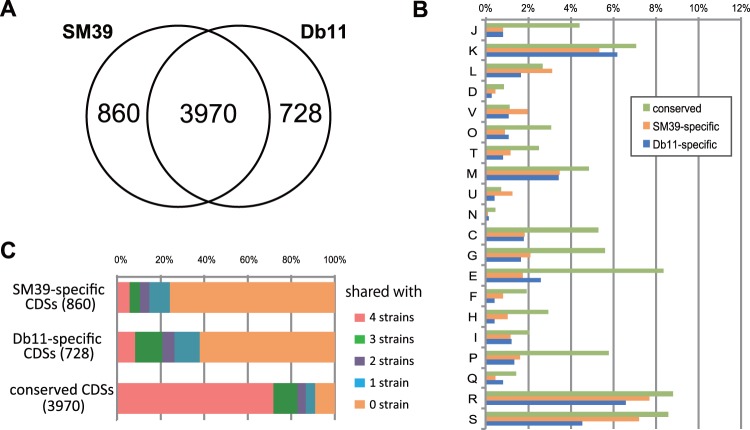
Comparison of the gene contents of SM39 and Db11. (A) Venn diagram showing the numbers of conserved and strain-specific CDSs. (B) COG category-based functional analysis of each group of CDSs, the conserved and strain-specific CDSs. J: translation, ribosomal structure, and biogenesis; K: transcription; L: replication, recombination, and repair; D: cell cycle control, cell division chromosome partitioning; V: defense mechanisms; O: posttranslational modification, protein turnover, and chaperones; T: signal transduction mechanisms; M: cell wall/membrane/envelope biogenesis; U: intracellular trafficking, secretion, and vesicular transport; N: Cell motility; C: energy production and conversion; G: carbohydrate transport and metabolism; E: amino acid transport and metabolism; F: nucleotide transport and metabolism; H: coenzyme transport and metabolism; I: lipid transport and metabolism; P: inorganic ion transport and metabolism; Q: secondary metabolites biosynthesis, transport, and catabolism; R: general function prediction only; S: function unknown. (C) Conservation of each group of CDSs in four strains of other Serratia species (S. proteamaculans 568, S. odorifera DSM4582, S. plymuthica 4Rx13, and S. plymuthica AS9).